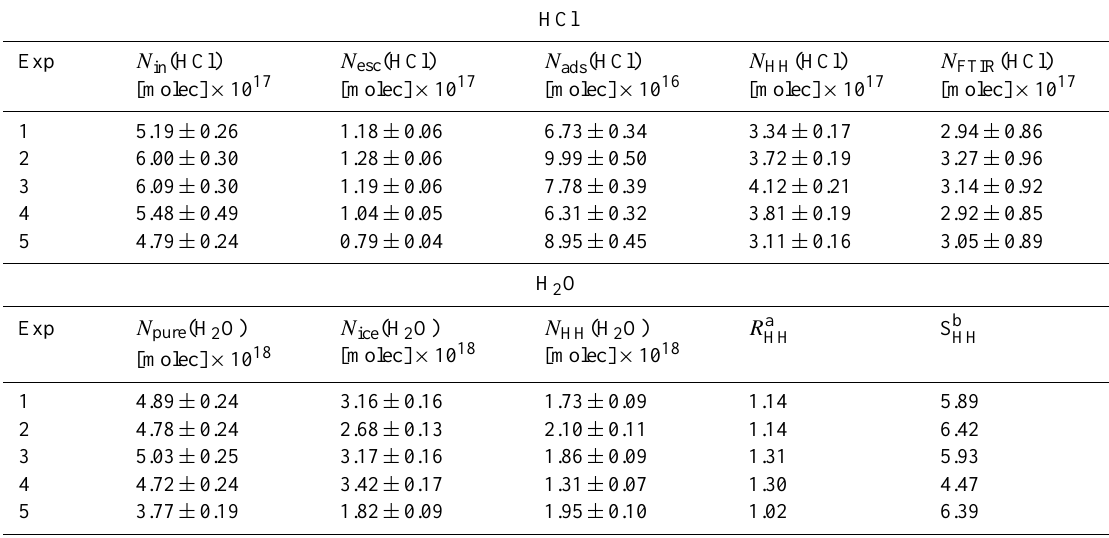
Table 3. Mass balance and stoichiometry for selected experiments on HCl crystalline